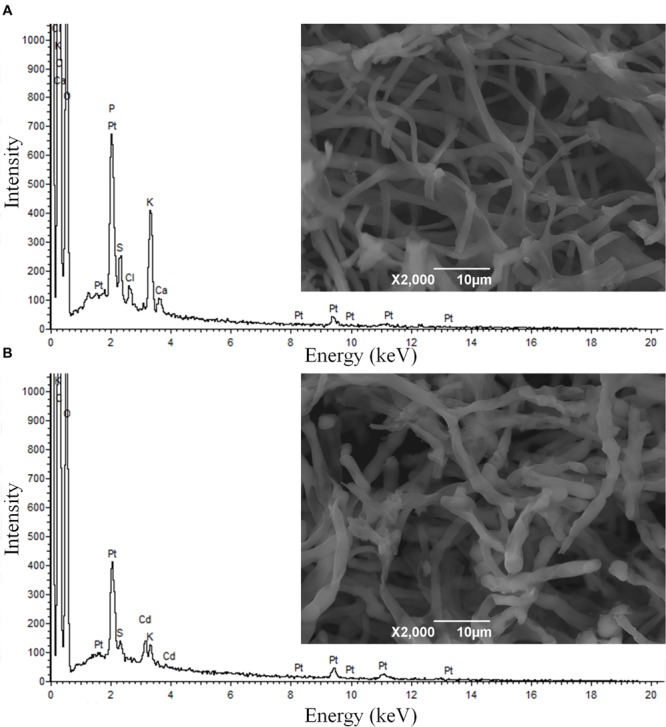
Scanning electron microscopy (SEM) micrographs and energy dispersive X-ray (EDX) spectra of Penicillium chrysogenum XJ-1 cultivated (A) in the absence of cadmium (Cd) and (B) in the presence of 1 mM Cd.